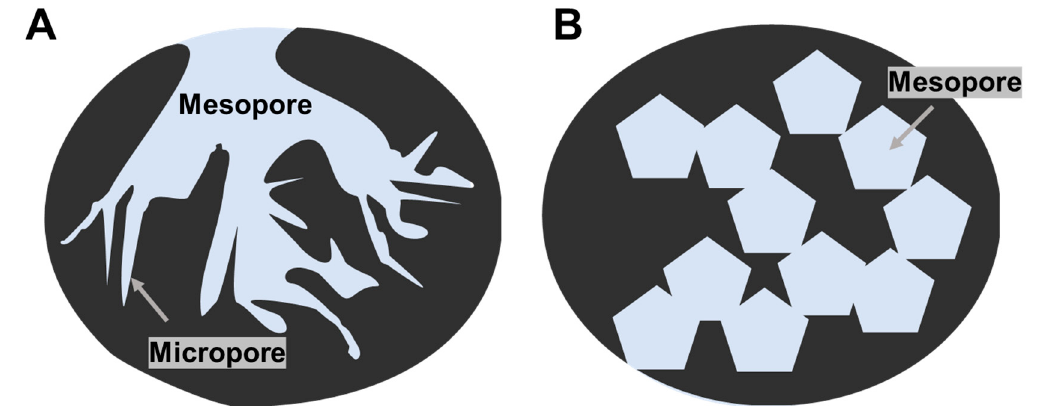
Figure 5. Schematic images of ( A ) typical activated-carbon and ( B ) MgO-templated